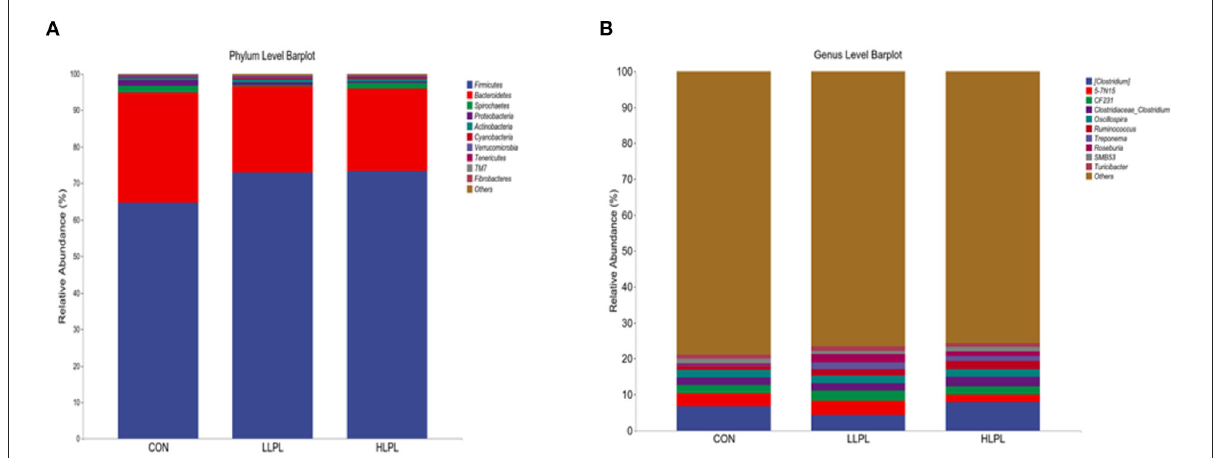
FIGURE2 Fecal bacterial phyla and genera in three treatments. (A) The bacterial taxonomic composition of fecal samples from the three treatments at the phylum level. (B) The bacterial taxonomic composition of fecal samples from the three treatments at the genus level (top 10, according to relative abundance). CON, control; LLPL, 0.5 g/kg lysophospholipids; HLPL, 0.75 g/kg lysophospholipids.